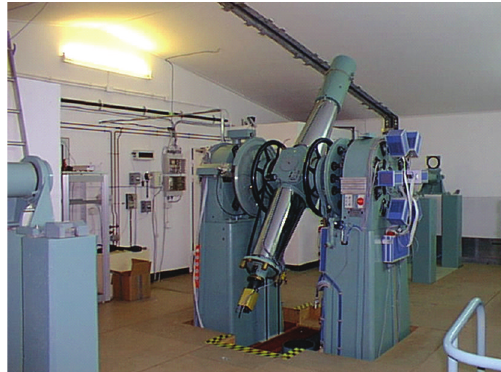
Figure 4: The Carlsberg Meridian Circle in La Palma was amongst the first automated telescopes, something achieved in 1984. It was until recently operated jointly by the Copenhagen University Observatory, the Institute of Astronomy, Cambridge, and the Real Instituto y Observatorio de la Armada en San Fernando (ROA); however it is now run solely by the ROA. Image was kindly provided by ROA.